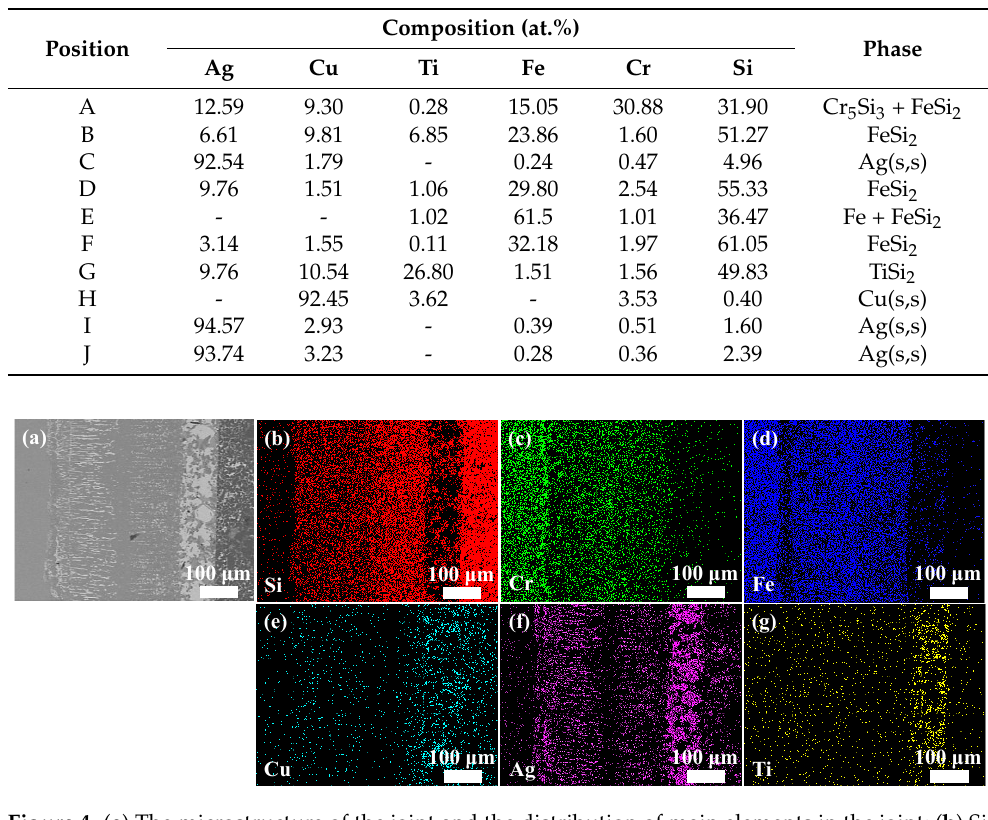
Figure 3. XRD pattern of PS-SiC-stainless steel joint: ( a ) Region I; ( b ) Region II; and ( c ) Region III. Table 2. EDS compositional analyses result of the joints. Composition (at.%) Position